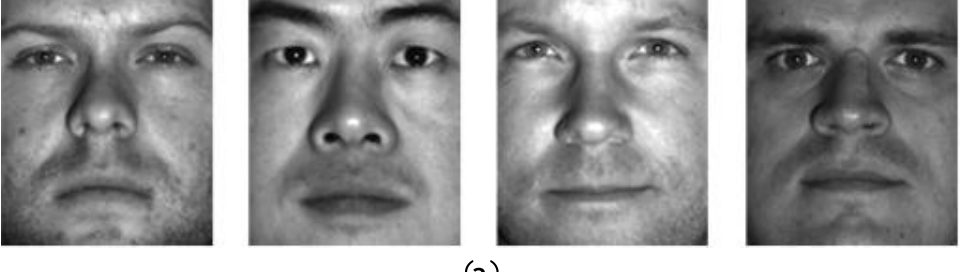
Figure 6. Face images of CroppedYaleB: ( a ) Eye-aligned images; ( b ) Misaligned